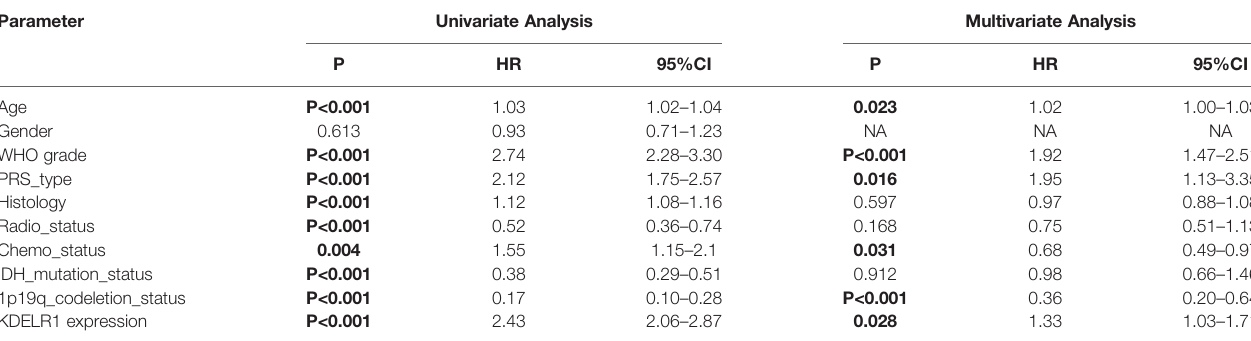
TABLE 2 | Cox regression analysis of KDELR1 expression as an independent survival predictor of gliomas in CGGA mRNAseq_325. Parameter